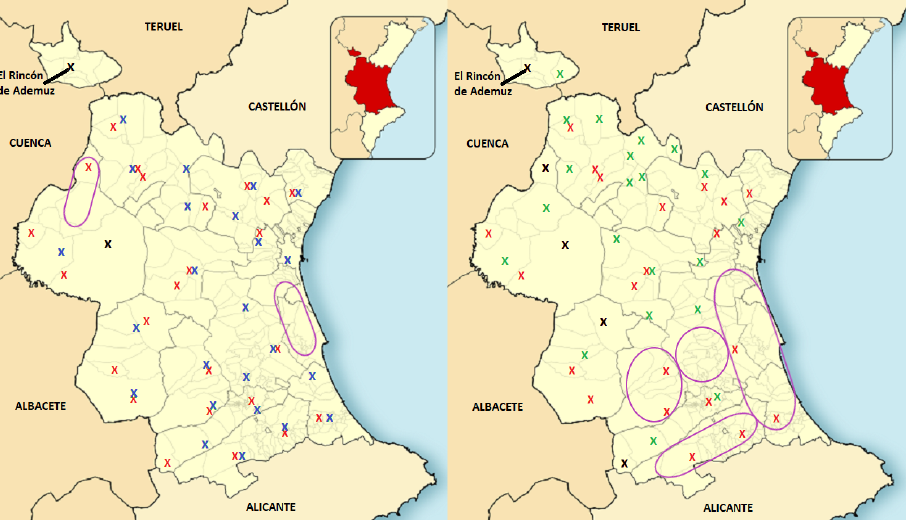
Figure 7. In the left image, the real stations (red Xs) are compared with those calculated by k -means (blue Xs), and in the right image, the same comparison is made with the results of running DBSCAN (green